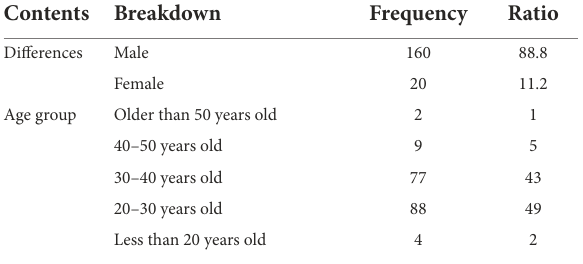
TABLE 1 Basic information of courier workers.